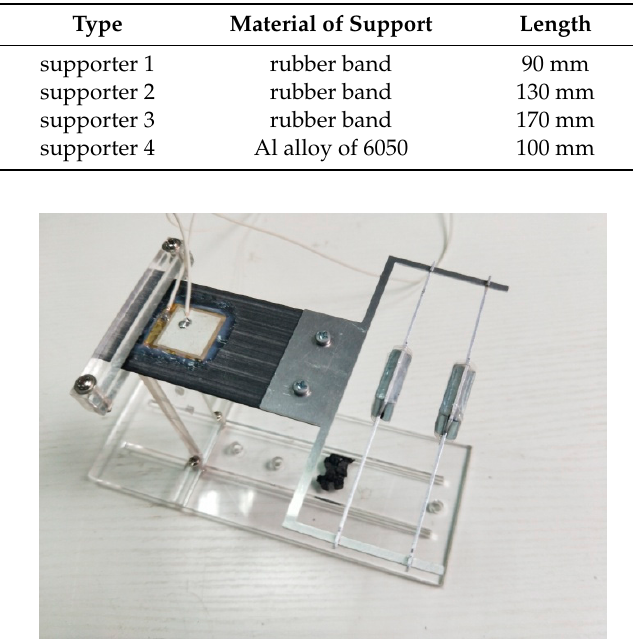
Figure 5. Physical prototype of supporter 4.